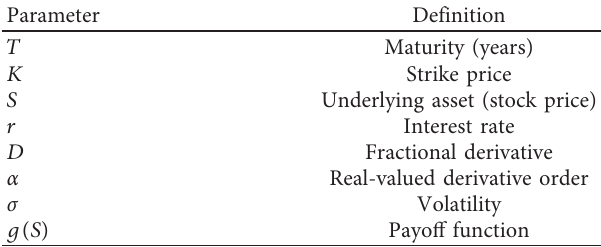
Table 1: Option parameters and their